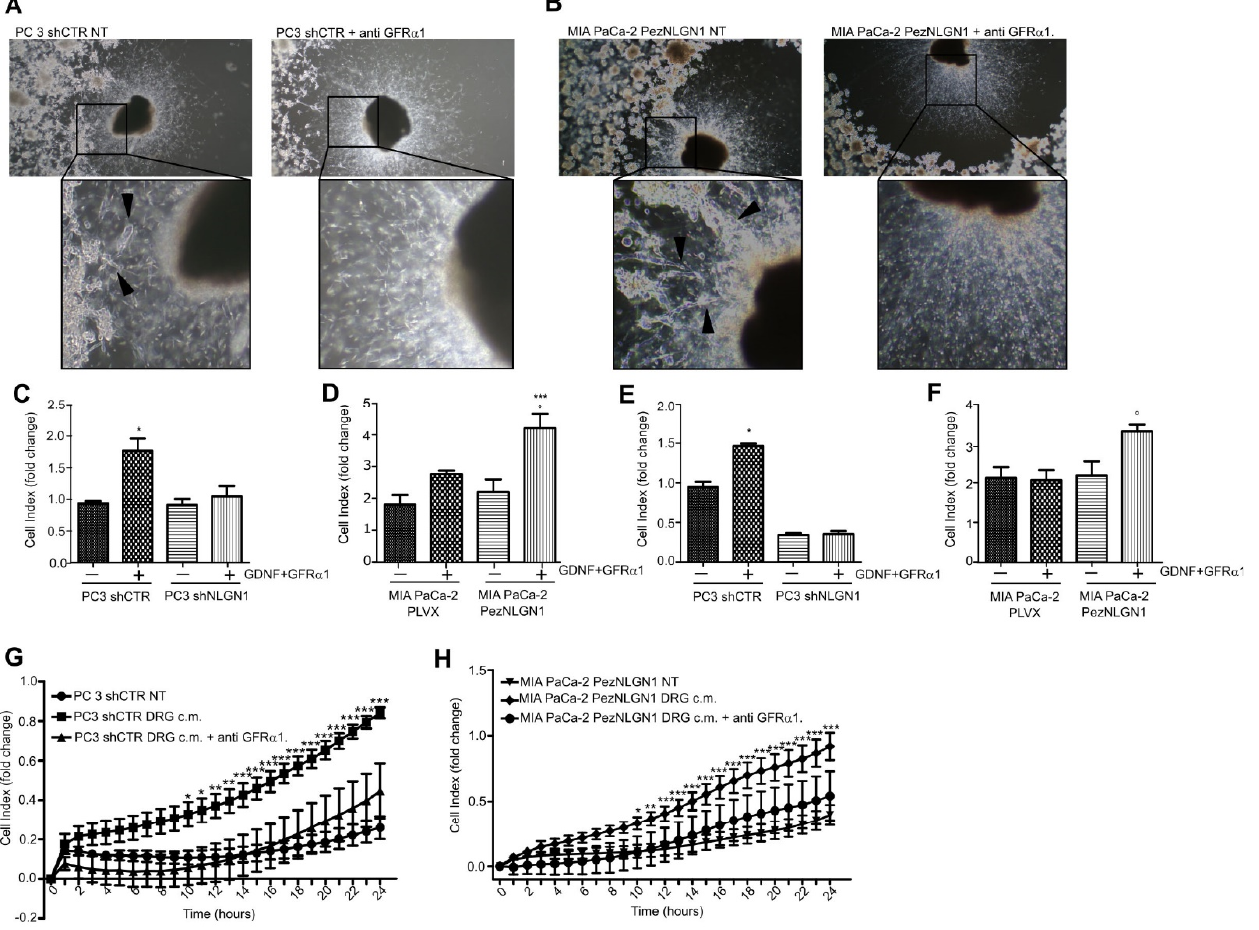
Figure 3 . NLGN1 and GDNF act synergistically in tumor–nerve connections. ( A , B ) Co-culture of murine DRG with PC3 shCTR ( A ) or MIA PaCa2 PezNLGN1 ( B ) cells in absence or in presence of a blocking antibody against GFR α 1. Black arrowheads in magnifications indicate PC3 shCTR ( A ) and MIA PaCa-2 PezNLGN1 ( B ) cancer cells contacting and mi- grating along the neurites toward the DRG body in absence of the GFR α 1-blocking antibody. In the presence of GFR α 1- blocking antibody, neurites appear free of invading cells (right panels in ( A , B ) with magnifications), which instead localize at the periphery of the well. Pictures were taken after 72 h and are representative of 1 out of 3 reproducible experiments performed in quadruplicate (original magnification 2.5×). ( C – F ) Migration ( C , D ) and invasion ( E , F ), through a 10 µg/mL layer of Matrigel, of PC3 shCTR and PC3 shNLGN1 ( C , E ) or MIA PaCa-2 PLVX and MIA PaCa-2 PezNLGN1 ( D , F ) by XCELLigence. Histograms show the migration and invasion rate in terms of cell index at the experimental end point (24 h) and values are expressed as the mean ± SE of 3 independent experiments performed in quadruplicate. One-way